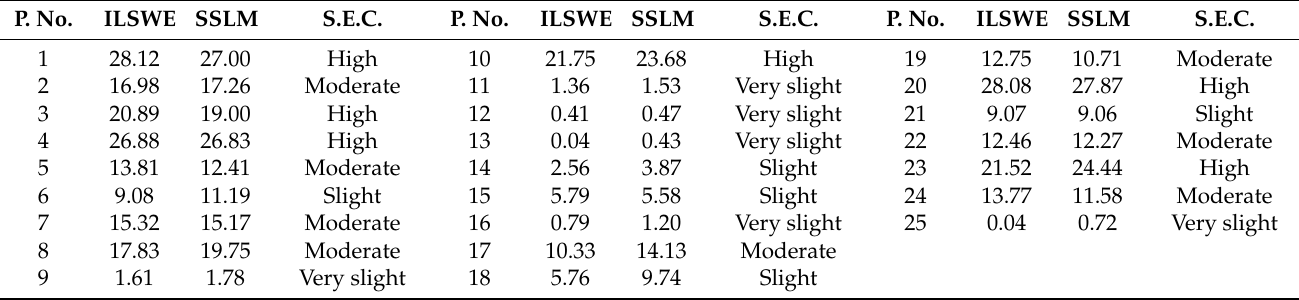
Table 13. Wind erosion indexes and classes according to the ILSWE model and the proposed model (SSLM). P.